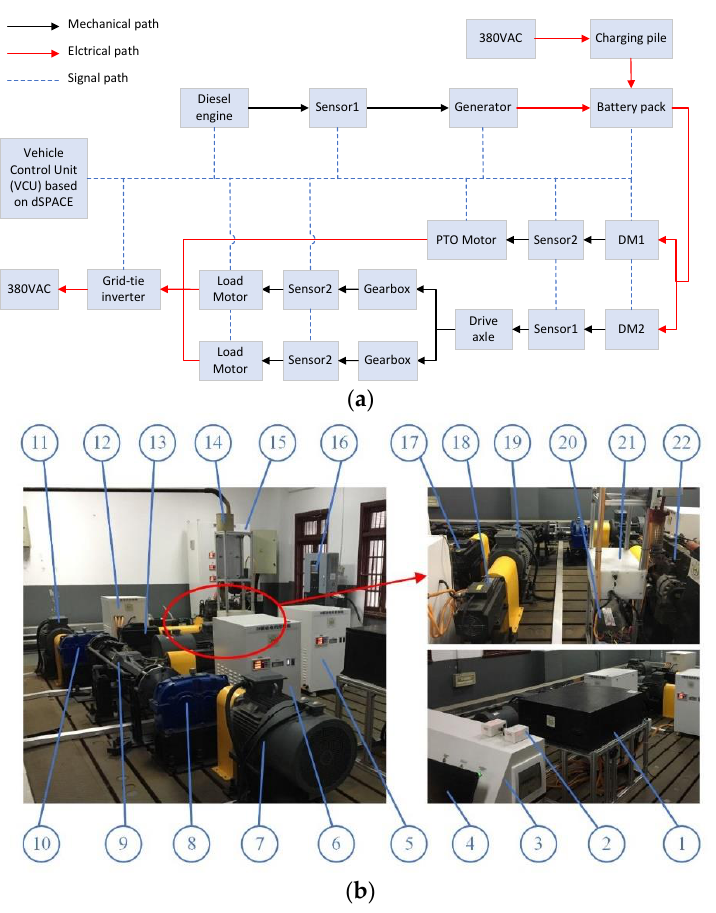
Figure 5. The test platform for a series hybrid electric tractor with a dual-motor-independent- driven powertrain: ( a ) structural scheme of the series hybrid electric tractor of the test platform; ( b ) photographs of the reconfiguration test platform. (1) battery pack; (2) communication converter; (3) operating console; (4) laptop; (5) control system of the drive motor 1; (6) control system of the drive motor 2; (7) right load motor; (8) right raising speed gearbox; (9) drive axle; (10) left raising speed gearbox; (11) left load motor; (12) generator control system; (13) generator; (14) exhaust pipe; (15) grid-connected inverter; (16) charging pile; (17) drive motor 2; (18) drive motor 1; (19) PTO motor; (20) lead–acid battery; (21) engine controller; (22) diesel engine. Note: torque-speed sensors are inside of the yellow